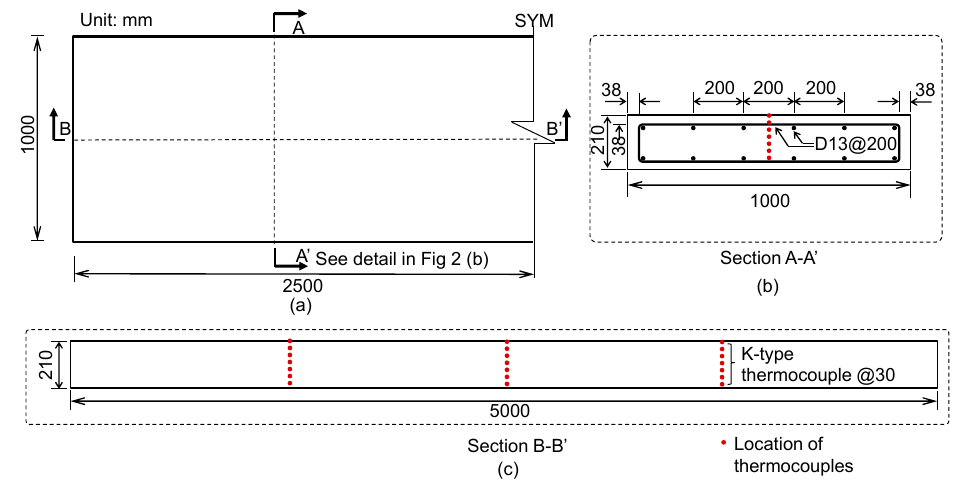
Figure 2. Design of the reinforced concrete slab specimen in this study: ( a ) plan view, ( b ) cross section (A-A’) and ( c ) cross section (B-B’) of the reinforced concrete slab specimen.